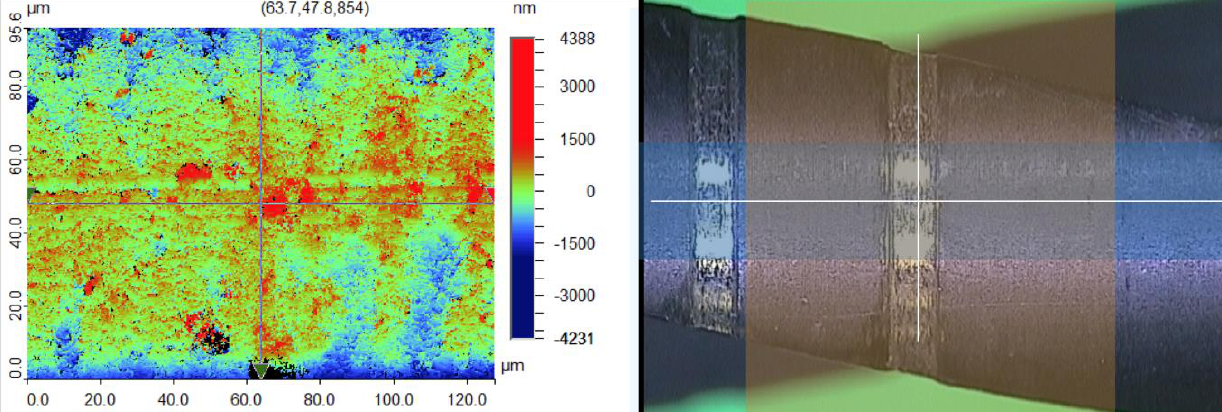
Figure 4. Evaluation of the wear roughness of drills by determining the maximum height (Sz).